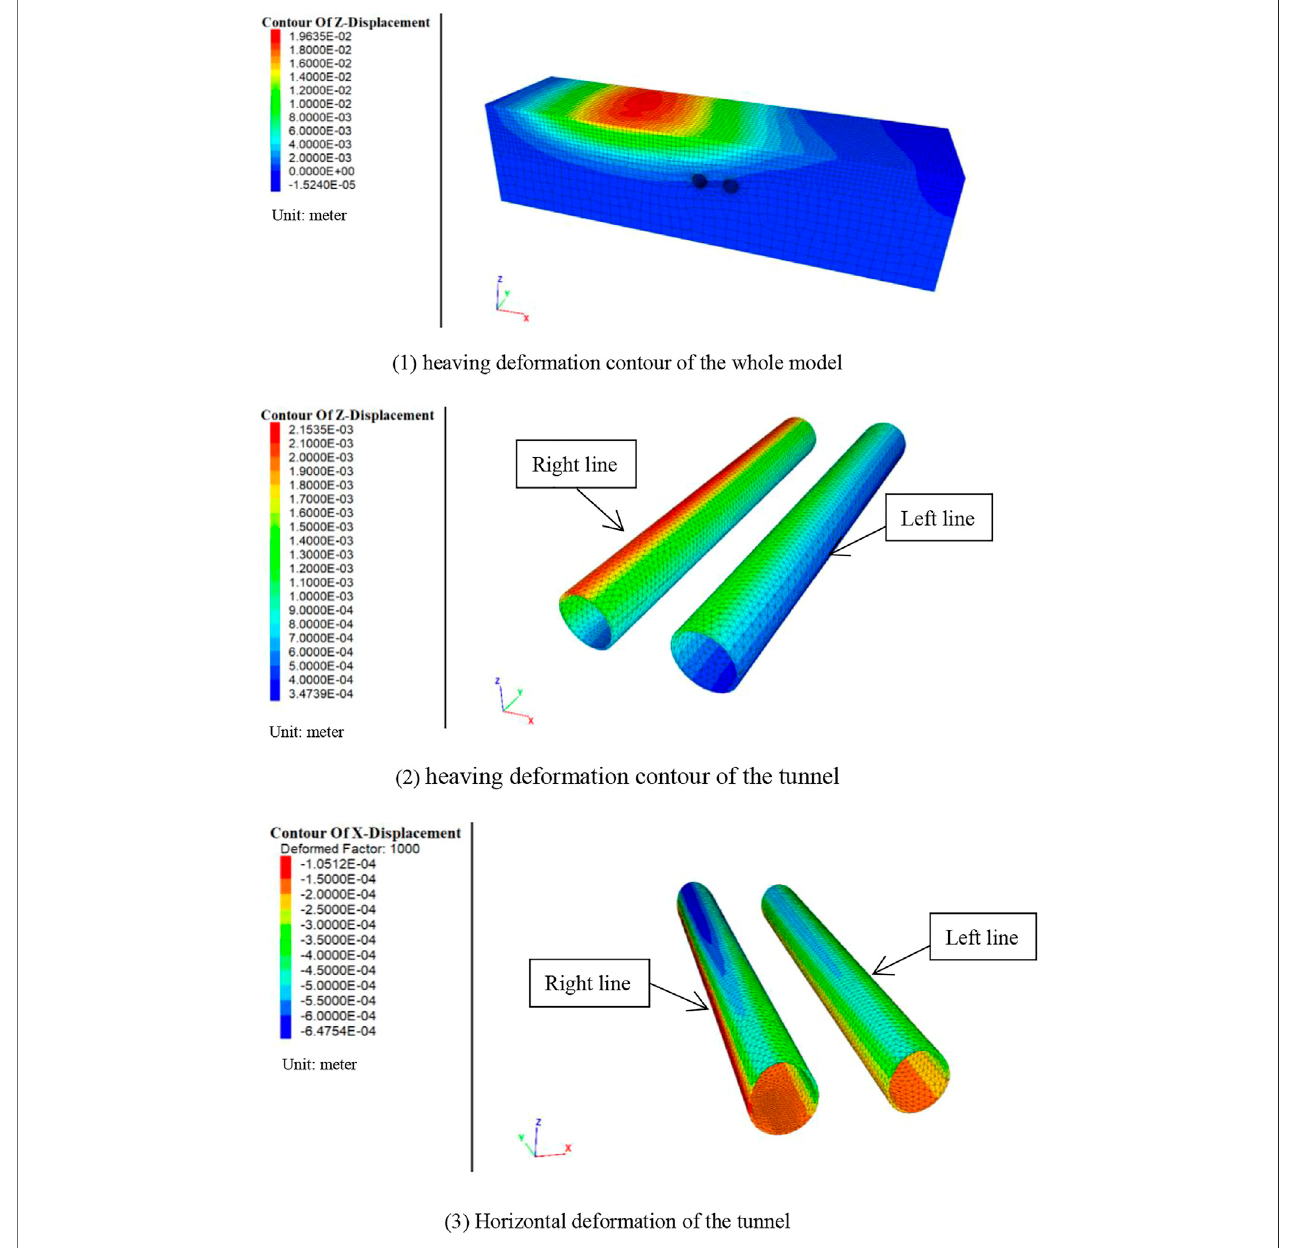
FIGURE 11 | Deformation contour of the two metro tunnels (heaving and horizontal deformation).